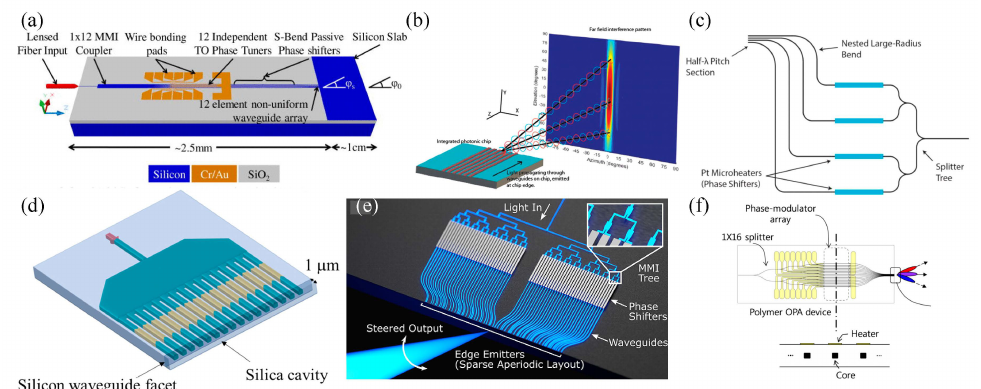
Figure 7. EF OPA structures. ( a ) A SOI-based EF OPA. Reproduced from [9] with the permission of AIP Publishing. ( b ) The first demonstrated half-wavelength spacing OPA. Reproduced from [61] with the permission of AIP Publishing. ( c ) A dispersion-engineered half-wavelength EF OPA with low crosstalk. Reprinted with permission from the author of [94] published on Arxiv, 2018. ( d ) A SOI-based EF OPA with a SiO 2 cavity for envelope tailoring. Reprinted with permission from [59] © The Optical Society. ( e ) A 1D 64-channel blue OPA with sparse aperiodic spacing. Reprinted with permission from [41] © The Optical Society. ( f ) Schematic of a 16-channel polymer EF OPA. Reprinted with permission from [98] © The Optical